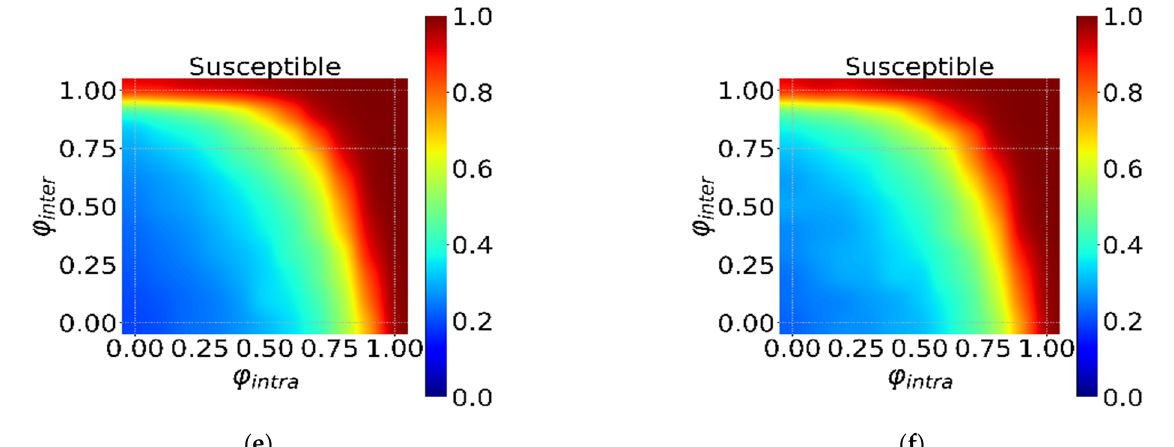
Figure 6. The interaction effect of the ϕ intra and ϕ inter under τ intra = τ inter = 0. The horizontal axis is ϕ intra , and the vertical axis is ϕ inter in ( a – f ). Different colors in the heatmap indicate different S . The ratio from dark red to dark blue transitions from 1 to 0 in turn. ( a – f ) show the different incubation periods E t ( E t = 0, 5, 10, 15, 20, 25).